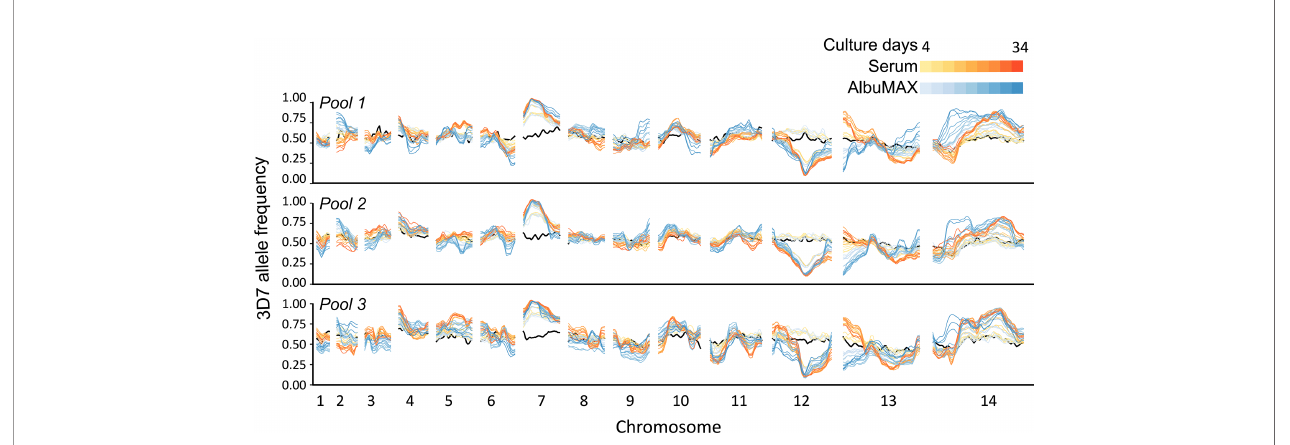
FIGURE 3 | Change in genome frequency under different culture conditions. The black lines show allele frequencies from the initial recombinant pools. Yellow-red lines show frequency changes in serum over time and light blue-dark blue lines show frequency changes over time in or AlbuMAX. The three plots show allele frequencies from the three recombinant pools (biological replicates). The lines with the same color in each panel show values for the two technical replicates.